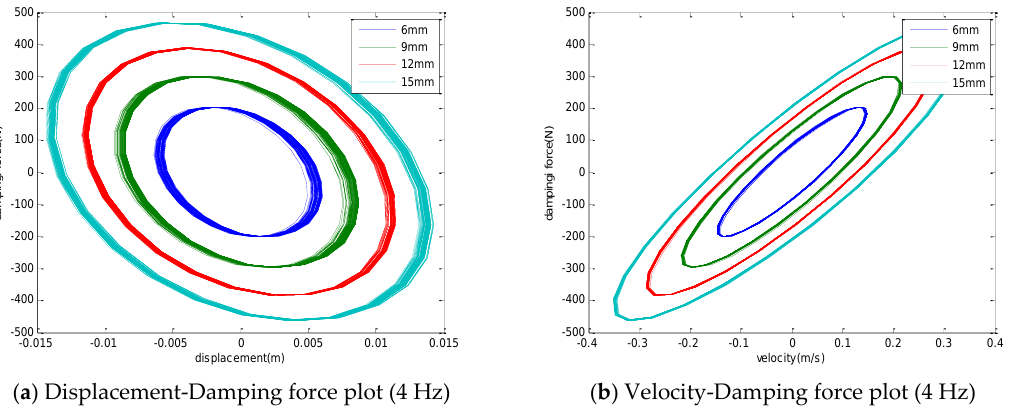
Figure 4. Hysteresis curve (4 Hz, various amplitude).